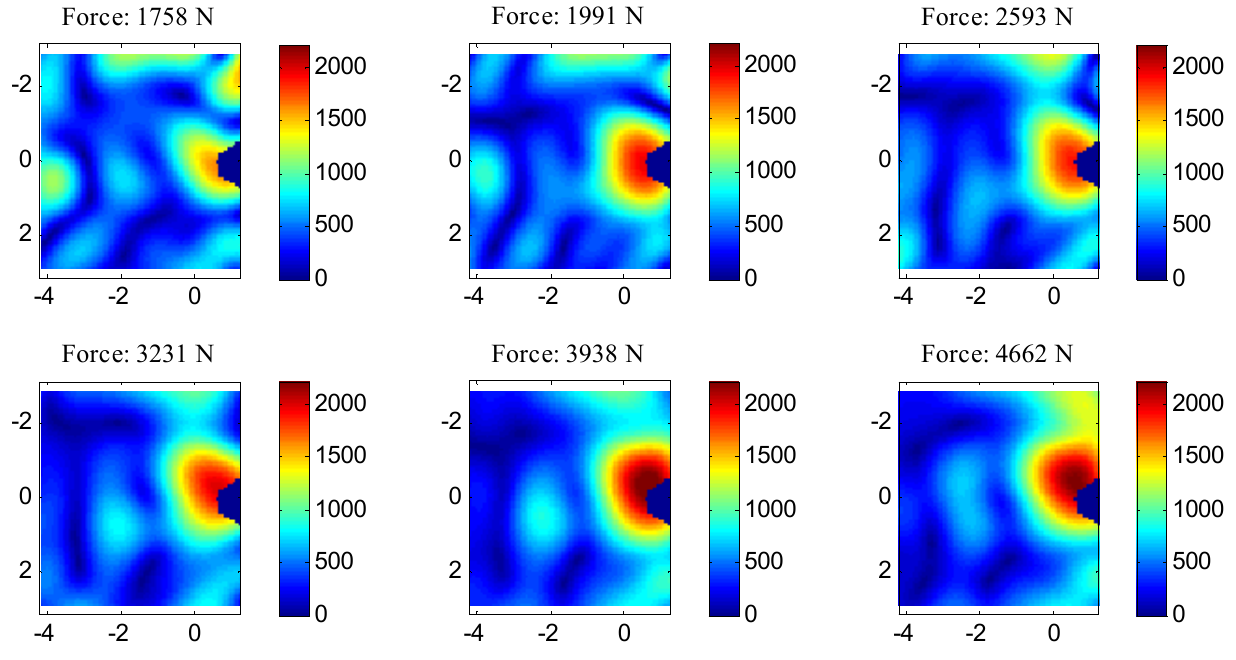
Figure 4: Identification of the plastic